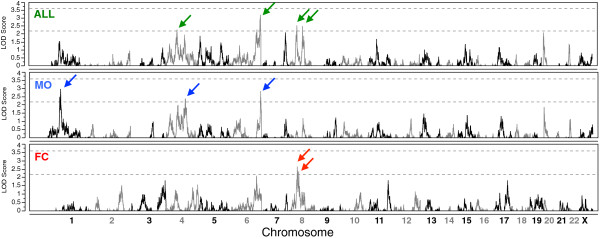
Genome-wide linkage: stage 1 sample. Logarithm of odds (LOD) scores from genome-wide, non-parametric, multipoint linkage analysis for autism spectrum disorder affection status in the stage 1 sample are plotted for autosomes (Merlin) and chromosome X (Minx). Top panel: all multiplex families (ALL); middle: male-only families (MO); bottom: female-containing families (FC). Dashed lines mark LOD thresholds 2.2 for suggestive and 3.6 for significant linkage [39]. Arrows note signals with LOD ≥2.2.